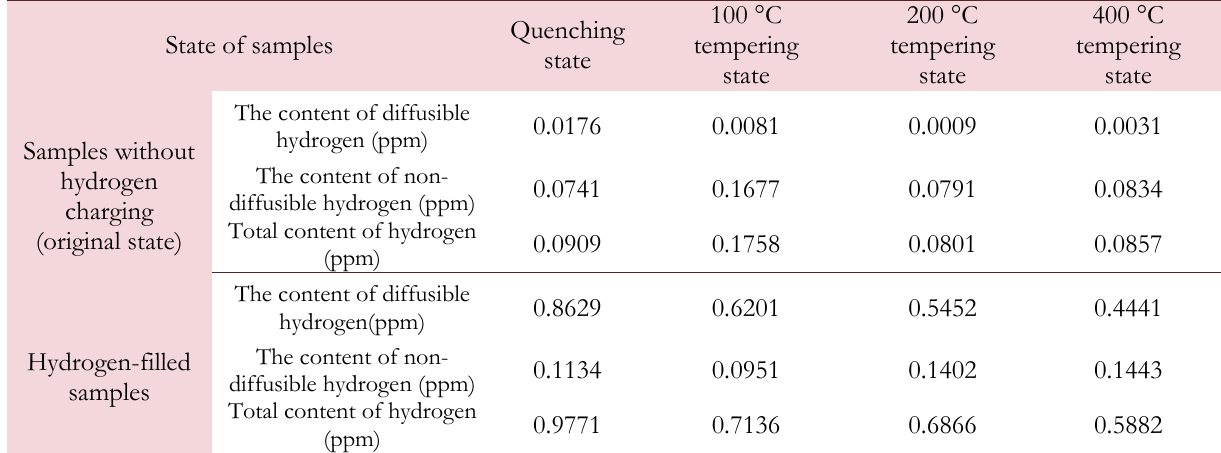
Table 3: The content of hydrogen of the experimental materials in different states before and after hydrogen charging (non-bearing, round bar samples).